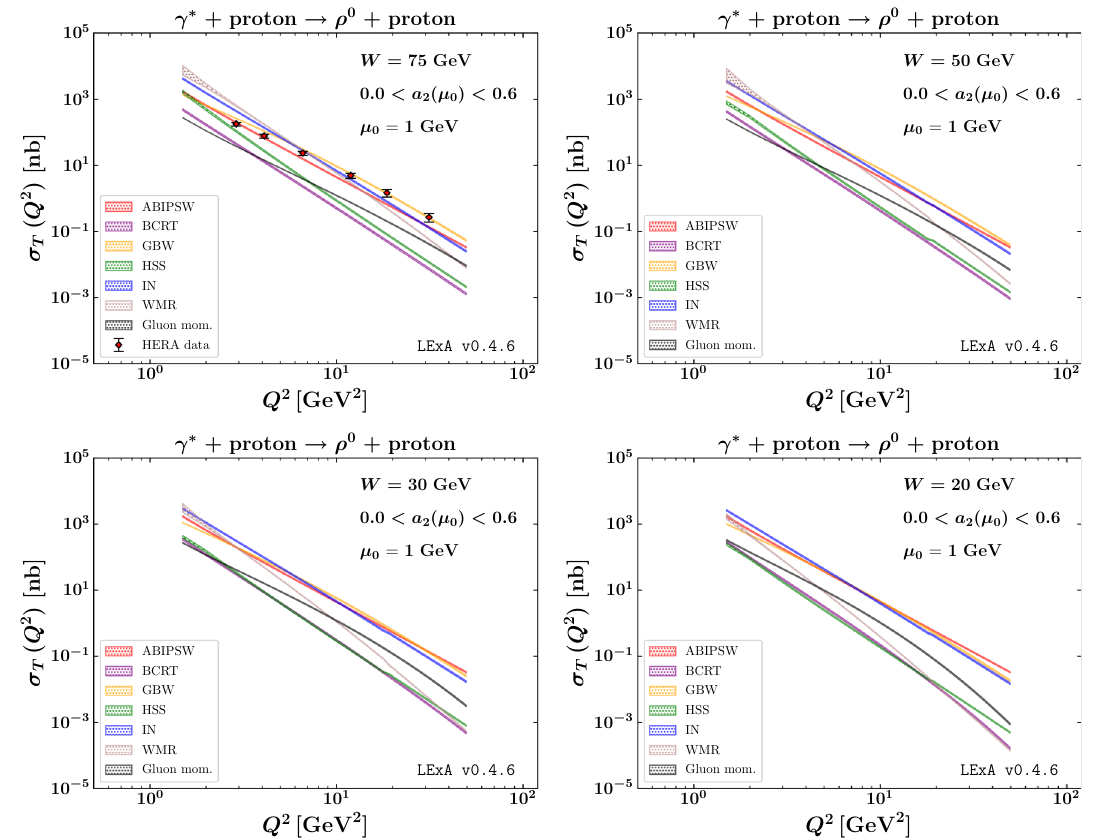
remaining panels). Uncertainty bands represent the effect of varying a 2 (μ 0 = 1GeV ) between 0 . 0 and 0 .